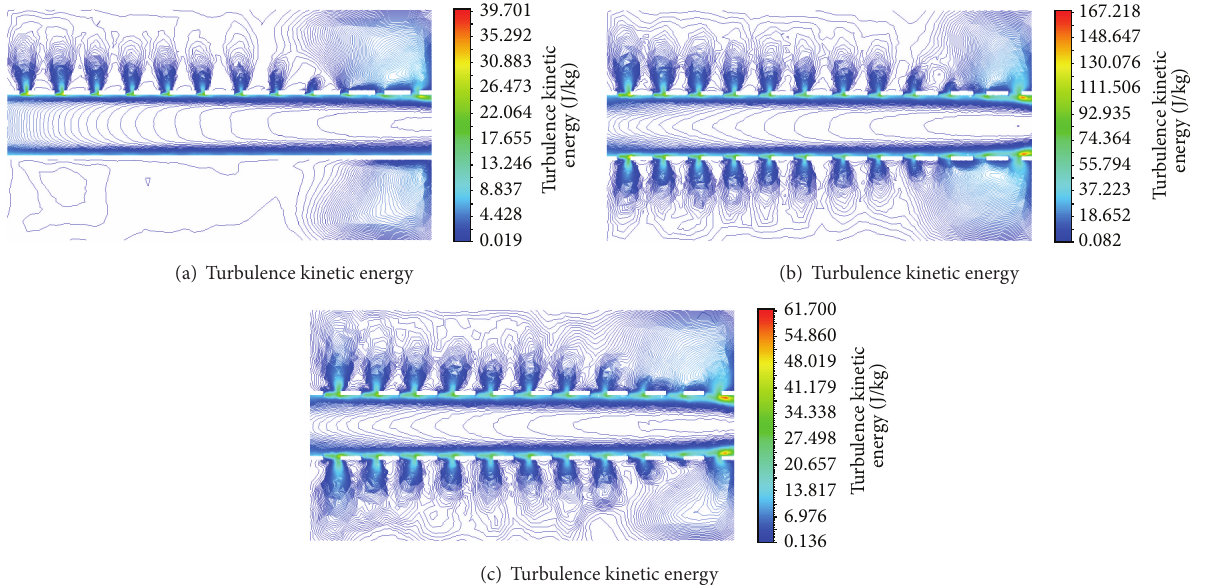
Figure 8: Counters of turbulent kinetic energy for the straight-through perforated pipe silencers: (a) silencer 𝑃 1 , 𝑀 = 0.1 , (b) silencer 𝑃 2 , 𝑀 = 0.1 . 𝑀 = 0.2 , and (c) silencer 𝑃 3 ,